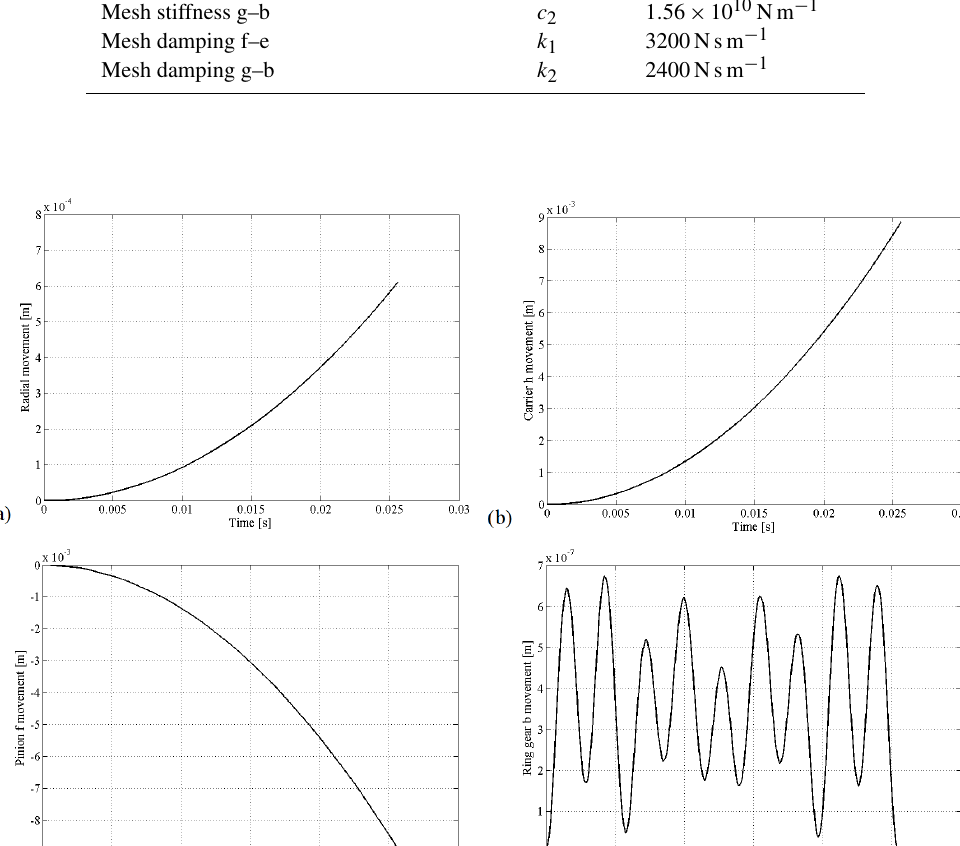
Mech. Sci., 12, 997–1003,